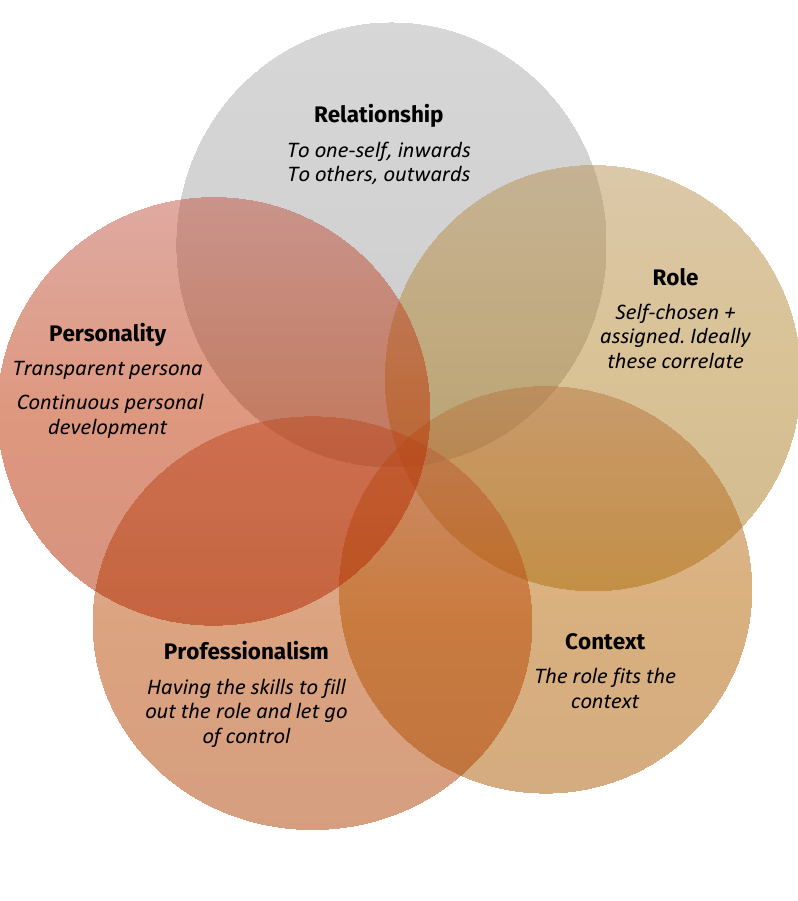
Figure 1.4. The Interconnected Elements of Authenticity Within Music